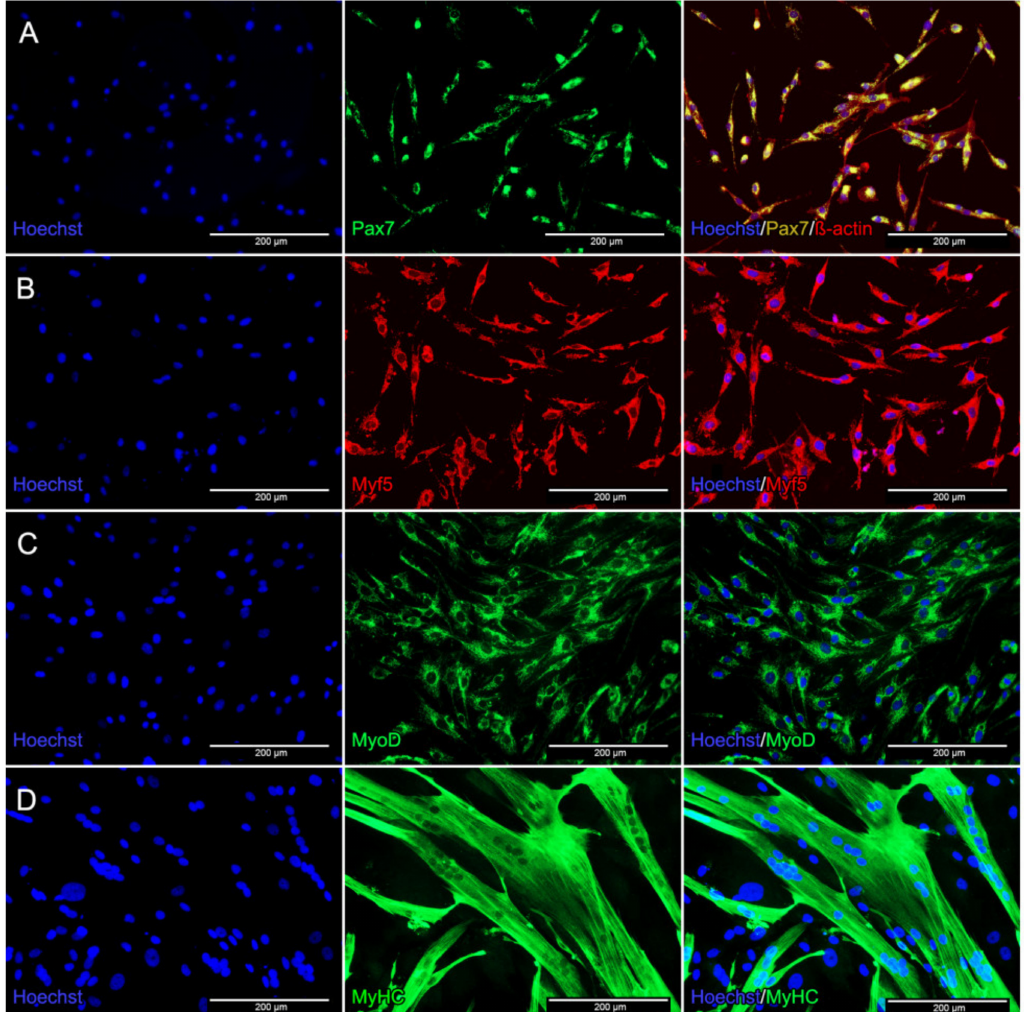
Figure 1. Immunofluorescence staining of primary human myoblasts and multinucleated myotubes. Myoblasts were stained for Pax7 and β -actin ( A ), Myf5 ( B ), and MyoD ( C ). After di ff erentiation, cells were stained for Myosin ( D ). Nuclei were stained with Hoechst dye